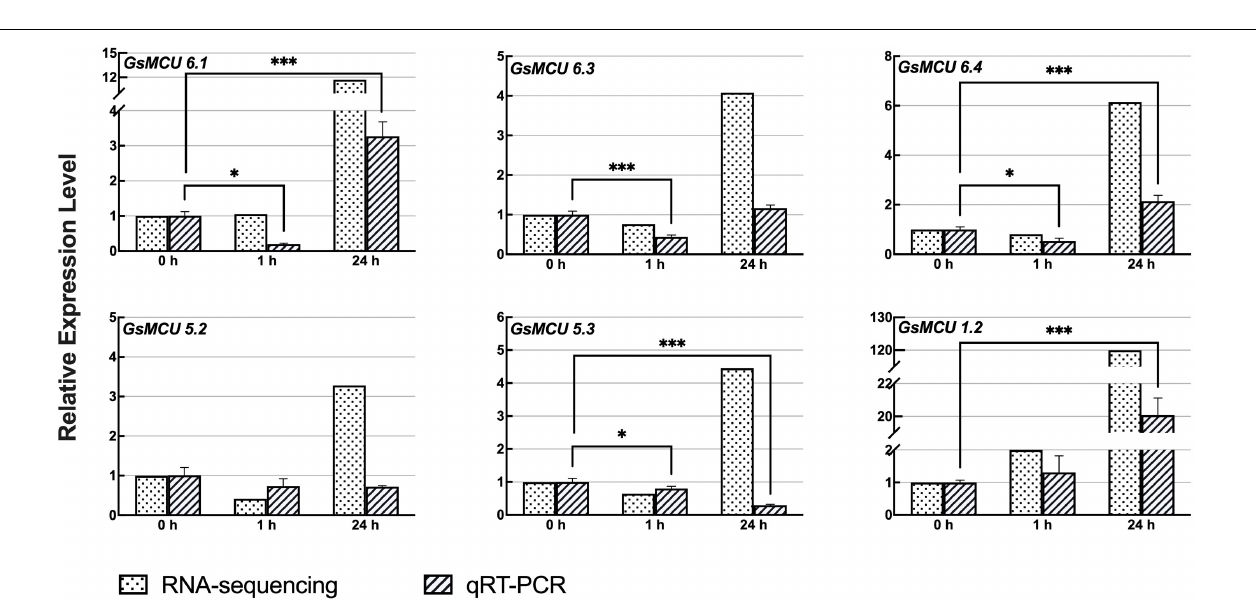
FIGURE 6 | Expression of GsMCU genes in different tissues. (A) Heat map showing the expression levels of soybean MCUs in different tissues. The color scale represents the expression values: red indicates high levels and blue represents low levels. (B–D) RT-PCR assays for GsMCUs expression in different tissues. F_box (GlysoPI483463.12G046600) was used as an internal reference.